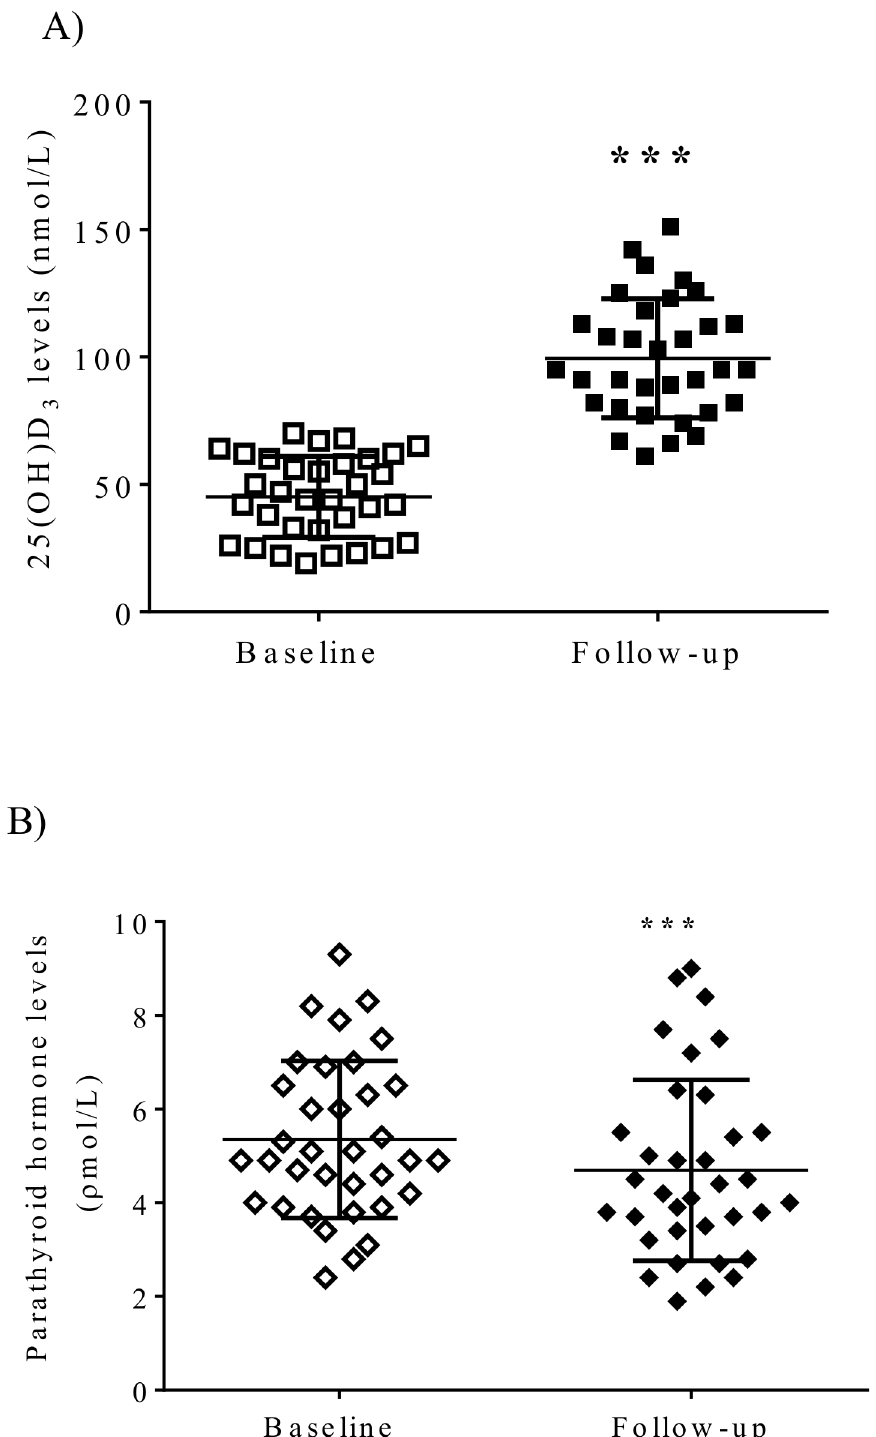
Fig 2. Significant changesof A) vitamin D levels and B) PTH levels with vitamin D replacement therapy in healthyvolunteers. *** p < 0.001.